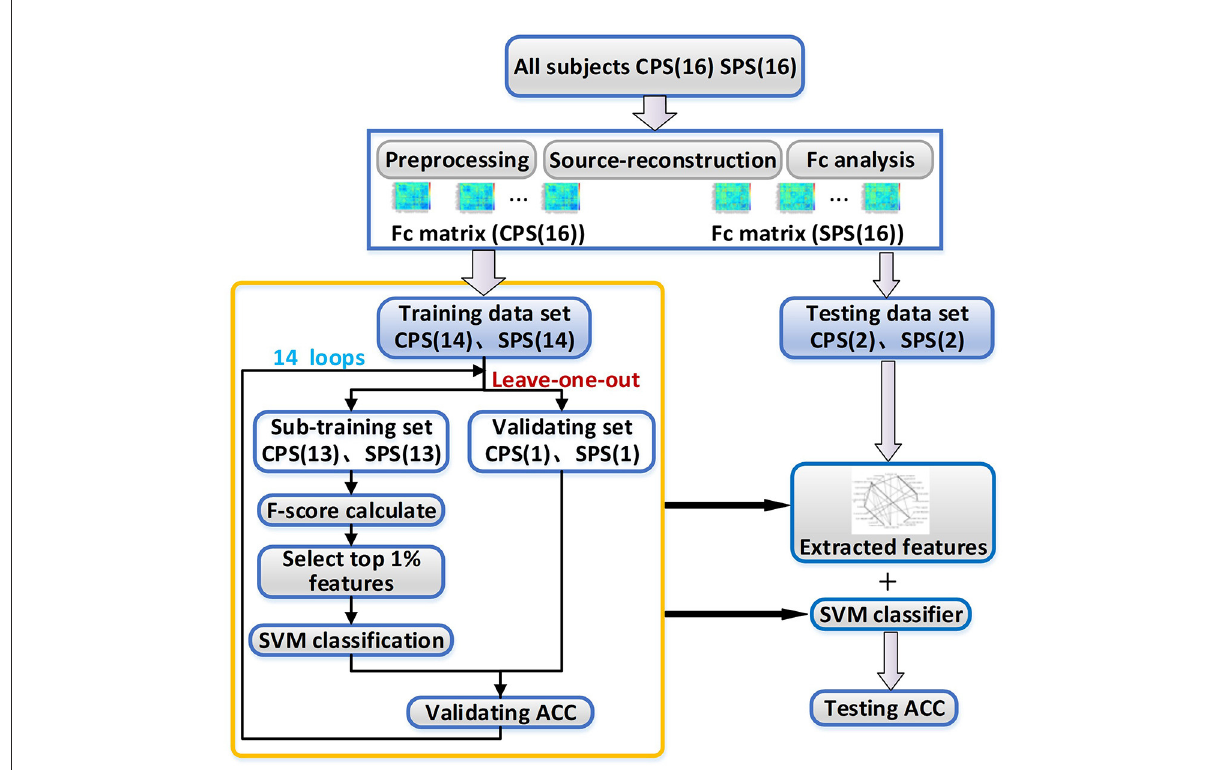
FIGURE1 The working flowchart of the proposed framework. CPS , complex partial seizures; SPS , simple partial seizures; SVM , support vector machine; ACC , the accuracy